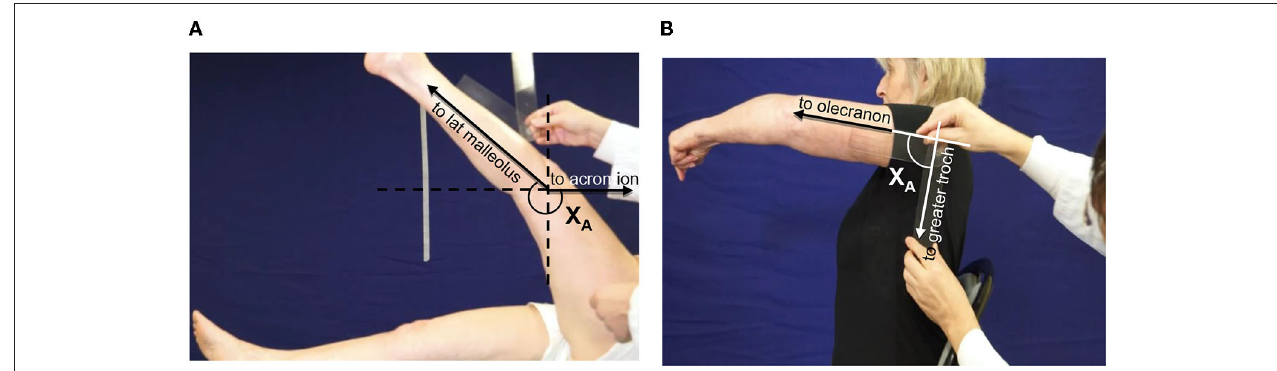
FIGURE 2 | Clinical assessment of active movement X A . (A) Hamstrings: patient supine, lower limb lying straight on the table. The clinician asks for a hip flexion keeping the knee extended. Axis of rotation: lateral condyle. The angle X A is measured between the two lines lateral condyle-external malleolus and lateral condyle-acromion (through projection, parallel to the line greater trochanter-acromion). (B) Shoulder extensors: patient seated, upper limb alongside the body. The clinician asks for a shoulder flexion keeping the elbow extended. Axis of rotation: acromion. The angle X A is measured between the two lines acromion-olecranon and